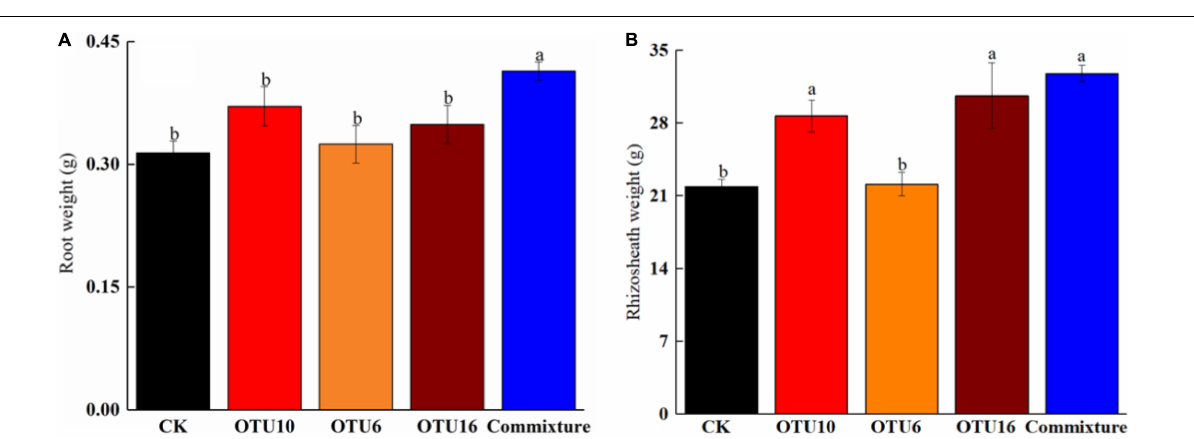
FIGURE 6 | Root-weight-promoting effects of bacterial strains isolated from K. hirsuta rhizosheaths (A) . Rhizosheath weight-promoting effects of bacterial strains isolated from K. hirsuta rhizosheaths (B) . The black column represent no infection (CK), the red column represent with OTU10 infected, the yellow column represent with OTU6 infected, the brown column represent with OTU16 infected, the blue column represent with commixture infected (OTU10, OTU6, and